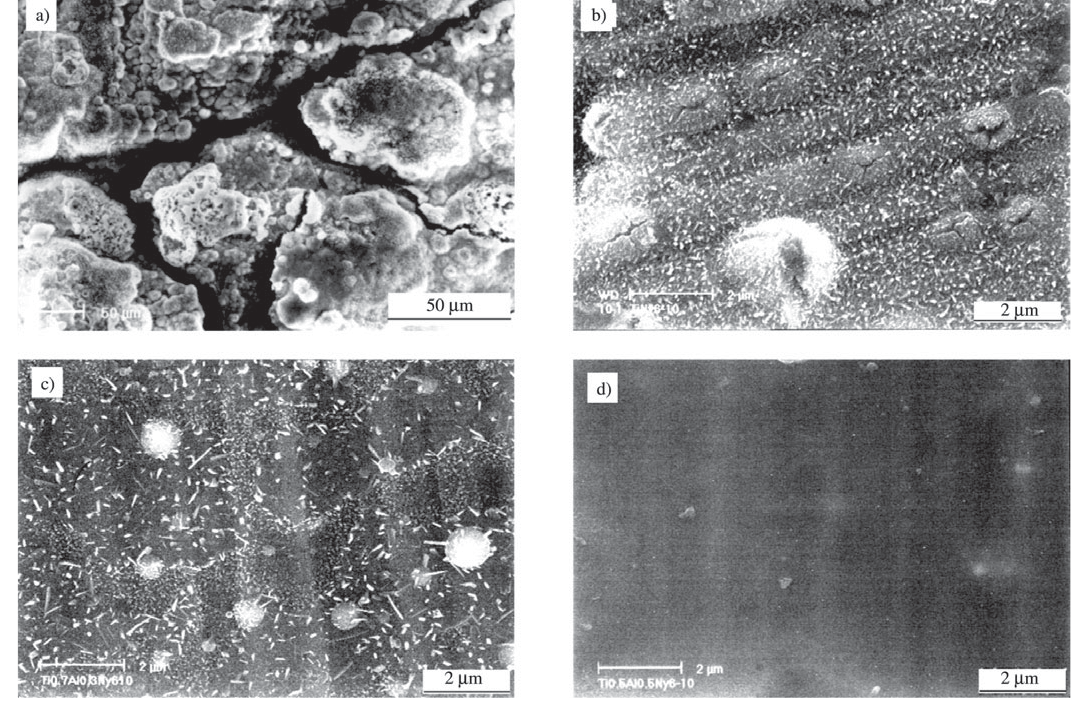
Figure 8. Surface Morphologies of 1Cr11Ni2W2MoV steel with coatings after 10h corrosion at 600 °C under synergistic effect of NaCl and water vapor a) bare steel; b) TiN; c) Ti